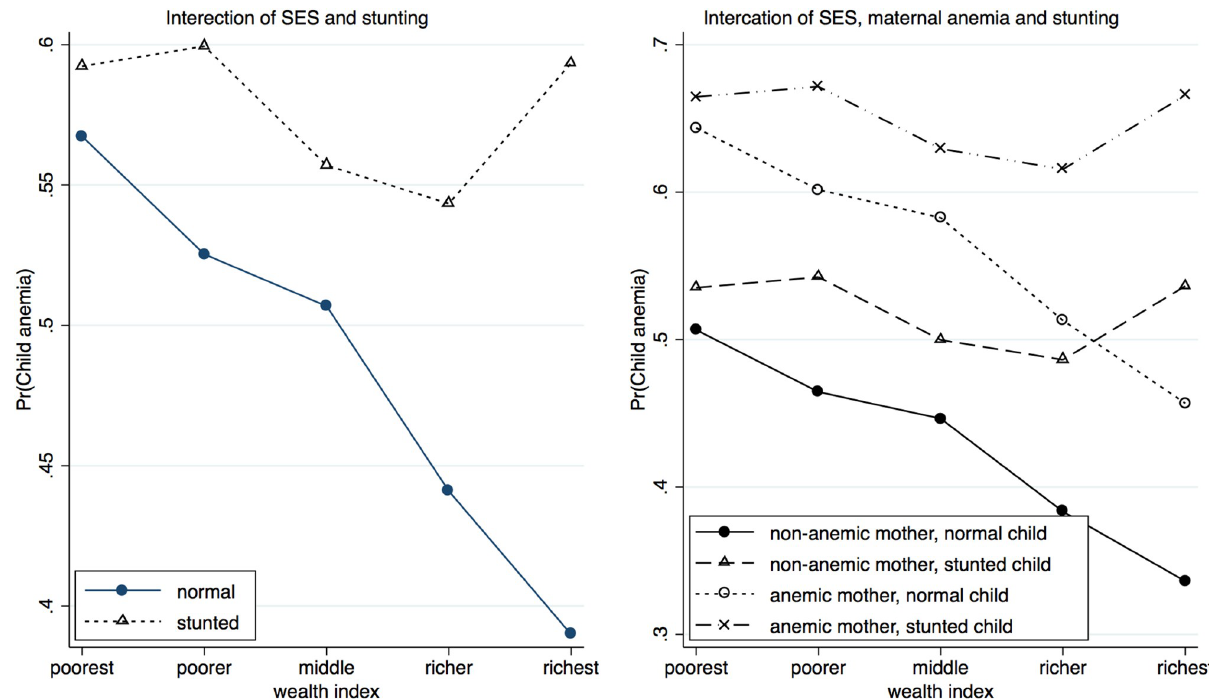
Fig 2. Interaction plots describing the association of stunting interact with SES, and maternal anemia, anemia separately on the risk of child anemia.